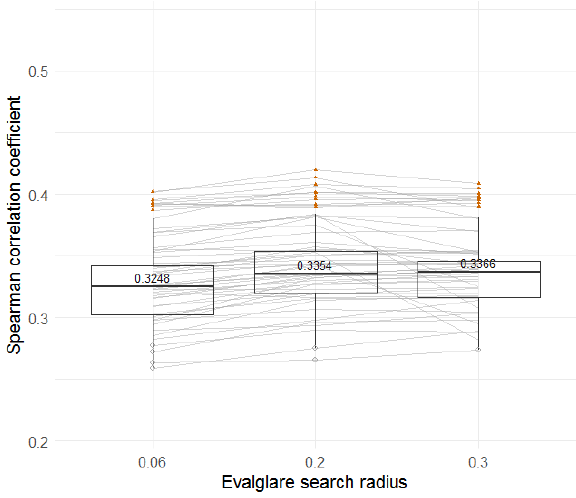
Figure 18. Boxplots of Spearman rho for the three search radius (field study).